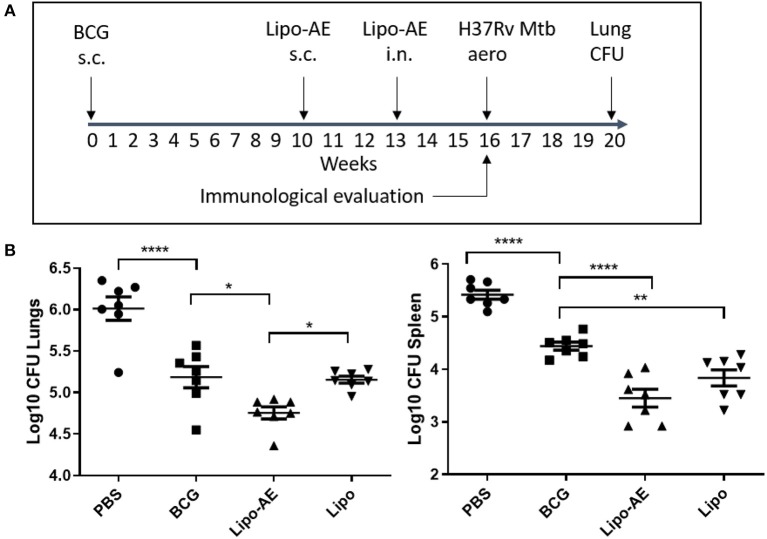
Reduced Mtb infection in Lipo-AE immunized mice. Four weeks after the final immunization, mice were challenged with aerosolised Mtb and then 4 weeks later culled and organs harvested for bacterial enumeration. Each point corresponds to log CFU value for the individual animals (n = 7). (A) Schematic depicting immunization and Mtb infection schedule. (B) CFU in the lungs and spleens. The horizontal bars represent the mean for each group ± SEM. Log transformed data were analyzed using a 1-way ANOVA and a Dunnett's multiple comparison test comparing all groups to the BCG control or comparing Lipo-AE with empty liposomes (Lipo); *P ≤ 0.05, **P ≤ 0.01, ****P ≤ 0.0001.